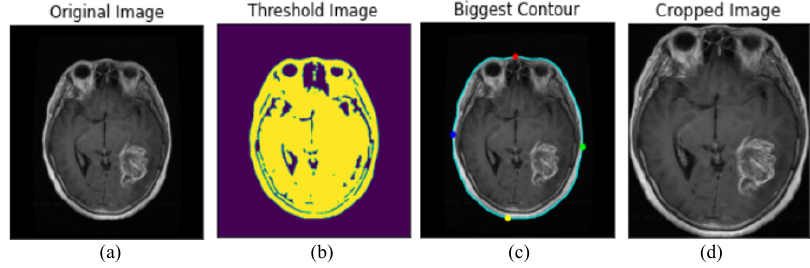
Fig. 2 Pre-processed images (a) Original MRI data; (b) Threshold image; (c) Contoured image; (d) Cropped